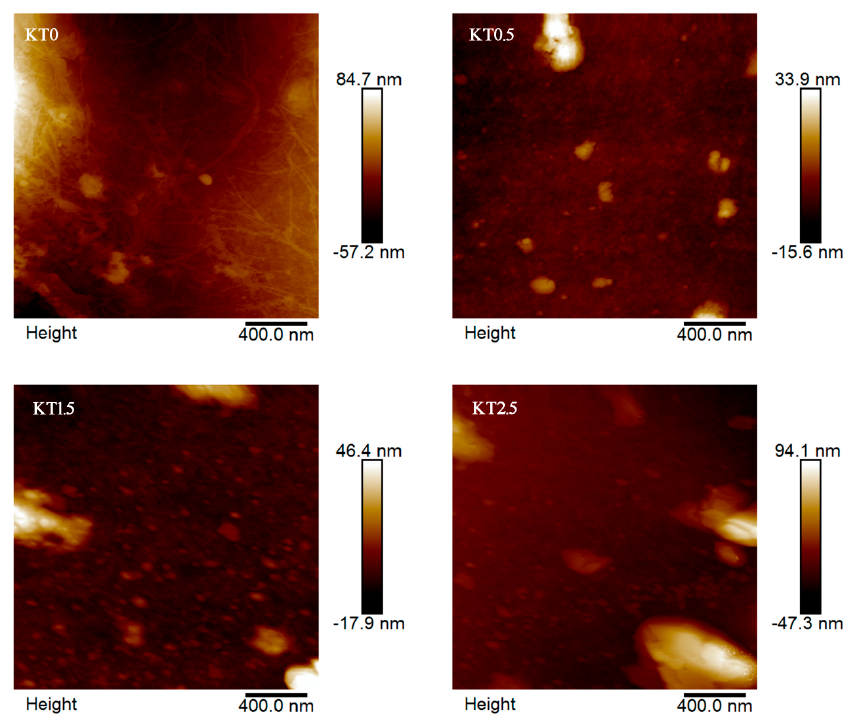
Figure 11. AFM images of the composite films (KT0, KT0.5, KT1.5, and KT2.5).